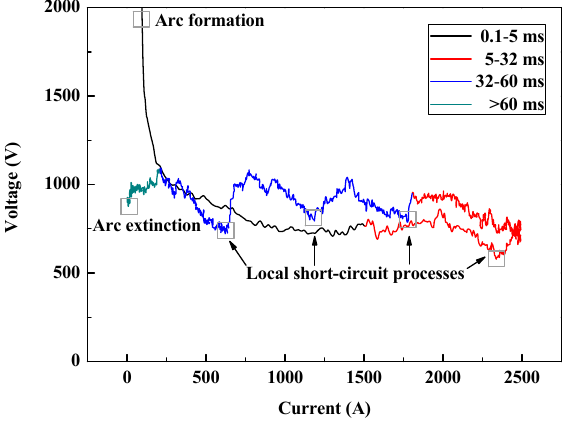
Figure 8. Variation of U-I characteristic of long free burning arc with time.